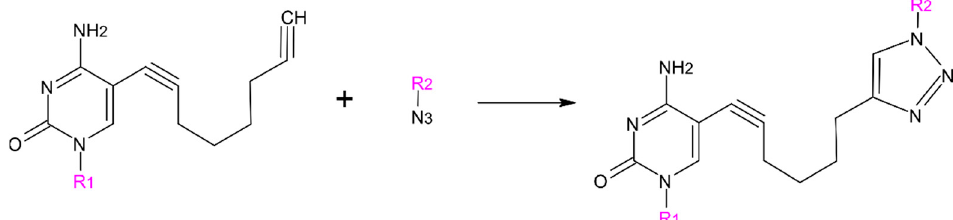
Figure 5. Illustration of the CLICK reaction enabling to link the oligonucleotide with peptide. R 1 —oligonucleotide, R 2 —peptide.